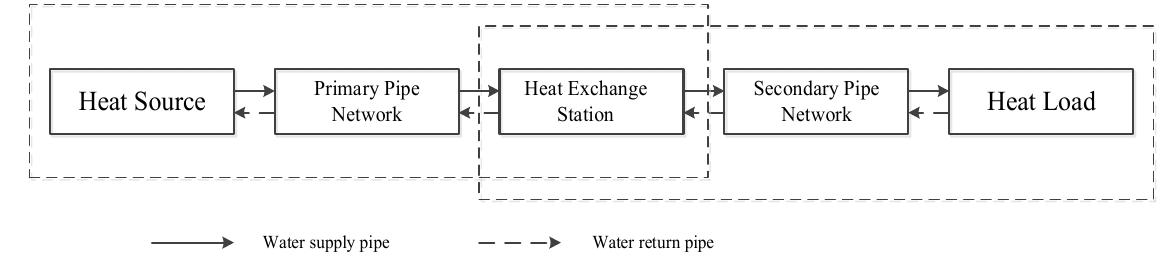
Figure 2. Basic structure of the thermal energy system.